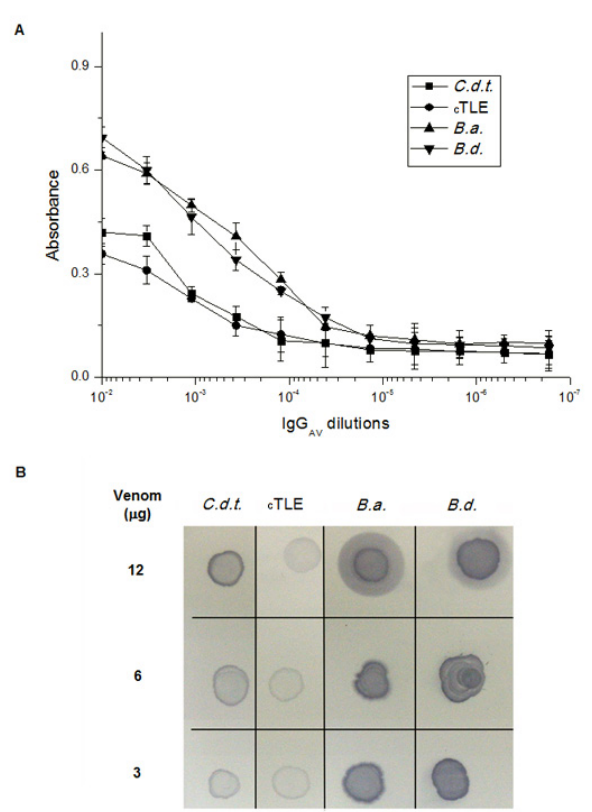
Figure 1. ( A ) Reactivity of IgG measured by av ELISA, with crotalic and bothropic venoms, and cTLE. ( B ) Dot blot analysis of whole bothropic and crotalic venoms and purified cTLE with IgG av antibodies. Control blots were carried out in the same conditions with PBS and did not show any spots. C.d.t .: Crotalus durissus terrificus ; cTLE: crotalic thrombin-like enzyme; B.a .: Bothrops alternates ; B.d. : Bothrops diporus